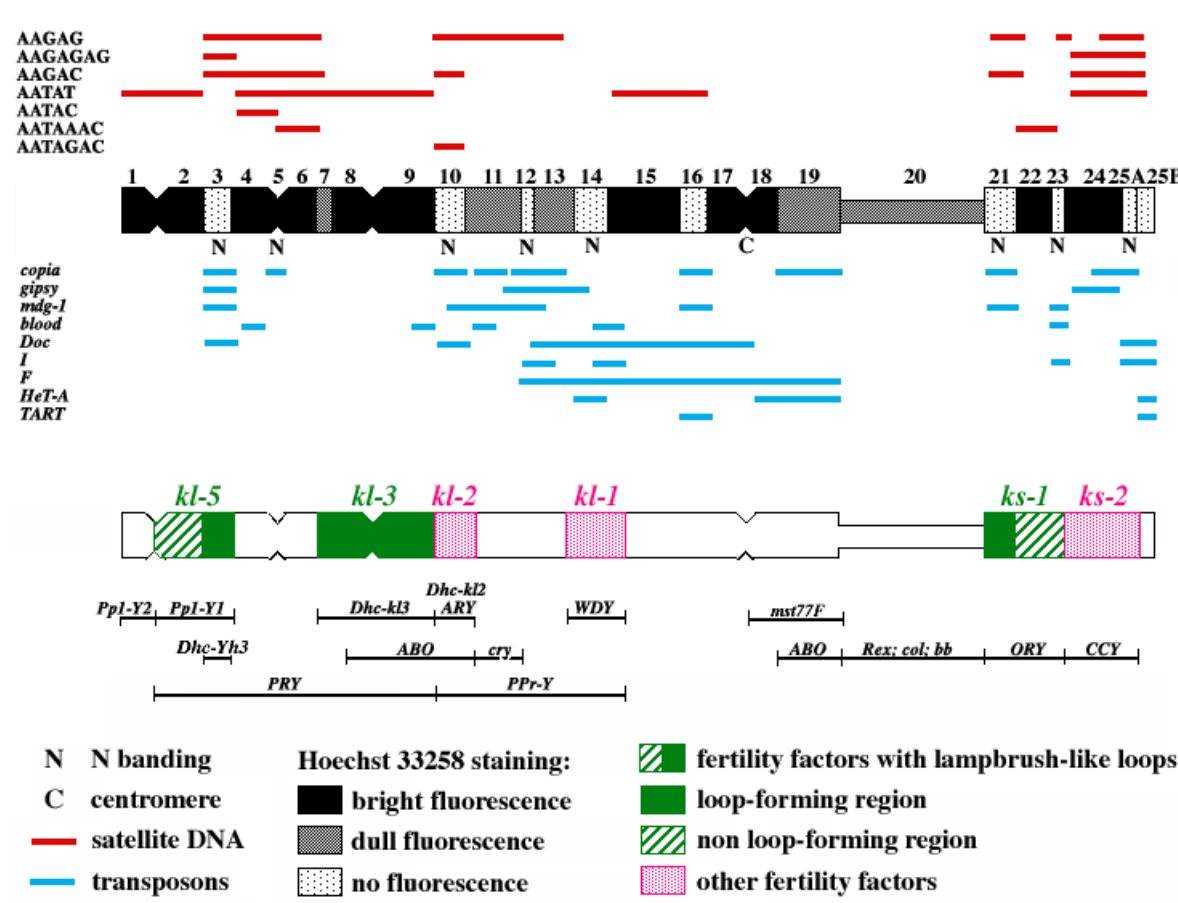
FIGURE 1. Schematic representation of the Y chromosome of D. melanogaster . All parts of the scheme are aligned with the Hoechst 33258 banding. From top to bottom: cytological localization of satellite DNAs[76,77]; Y chromosome diagram showing N banding and Hoechst 33258 banding[75,78]; cytological localization of transposable elements[79,80]; Y chromosome diagram showing the cytological localization and organization of six[78] of the fertility factors described by Brosseau[81]; other genetic elements mapping on the Y chromosome[78,82,83,84,85,86,87]. (Note on the image: this picture is reprinted from Piergentili and Mencarelli[88] and modified according to Vibranovski et al.[86]; no data are available to date about the location of the fdy